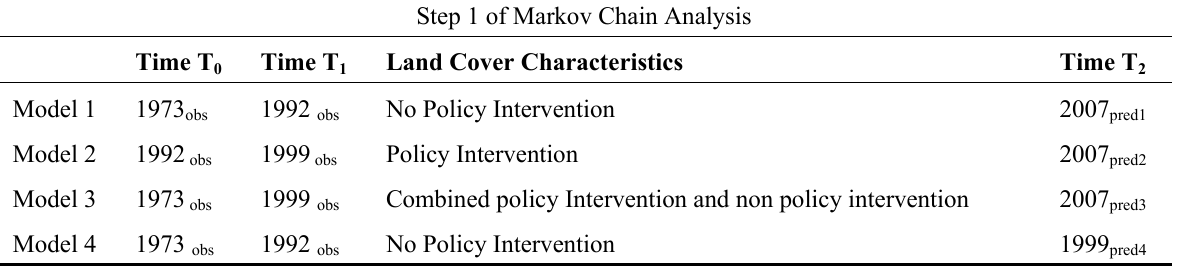
Table 2. Four Cellular automata (CA) Markov models predicting 1999 and 2007 land-covers. Observed land-covers for a given year is denoted by ‘obs’ and predicted land-covers for a given year is denoted by